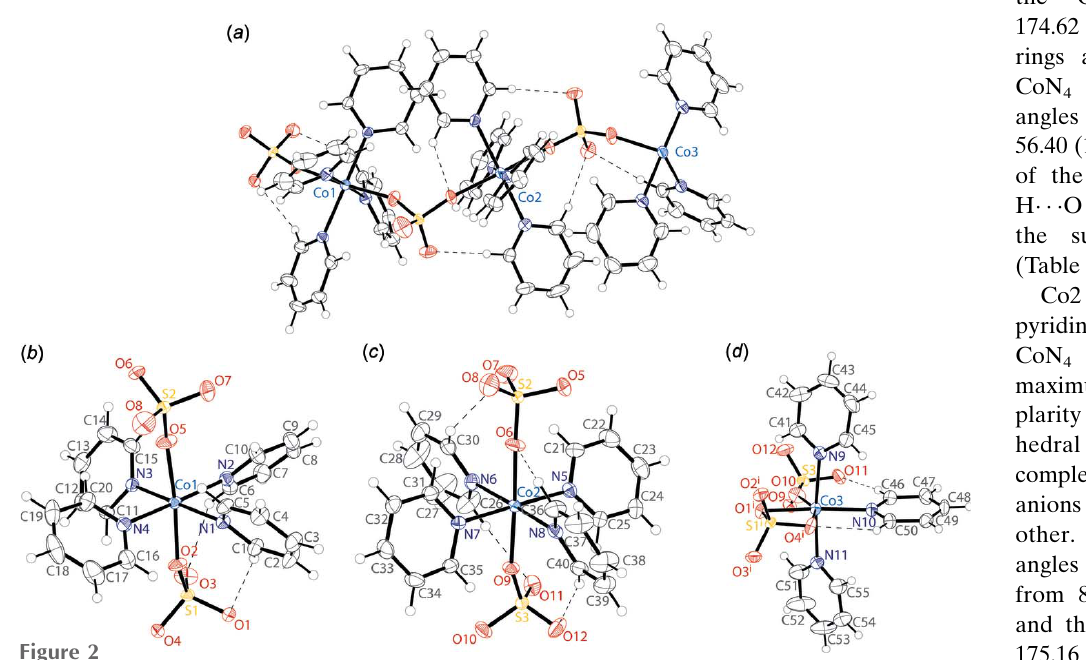
(cid:5) x , 1 (cid:5) y , (cid:5) 1 + z ] 2 2